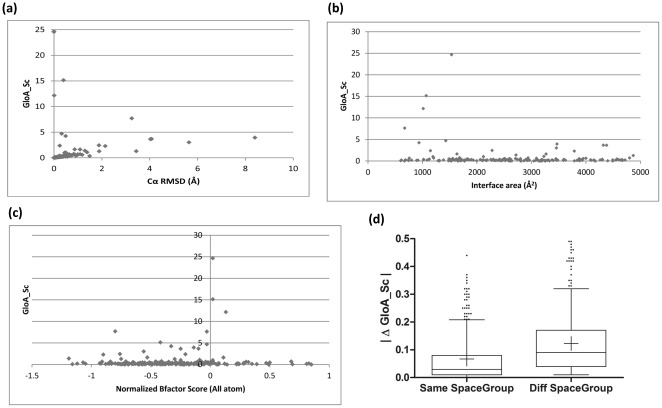
Molecular aspects of asymmetry.This figure shows the correlation of mathematical asymmetry captured by GloA_Sc with a) Cα-RMSD b) interface area c) normalized B-factors and d) crystal packing. Figures a,b,and c are scatter plots in which the molecular parameter being studied is shown along the X-axis and GloA_Sc along the Y-axis. In b), a subset of the overall graph cotnaining the majority of data is shown for clarity (with the maximum interface area being ∼25000 Å2). Figure d) is a box-plot representation of the absolute difference in GloA_Sc for the pairs of homodimers in each dataset. The horizontal bars present the 5 percentile, 25 percentile, 50 percentile, 75 percentile and 95 percentile values of each distribution and the mean value as ‘+’. Outliers are represented as dots.